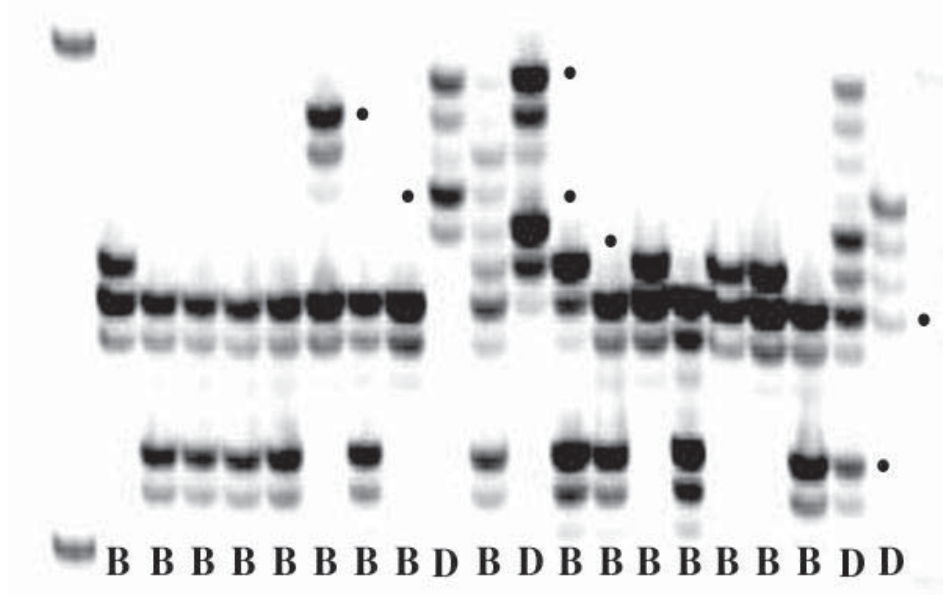
Figure 4. Amplification products of a pair of simple sequence repeat primers in Puccinia triticina . Bands with dots are alleles. B = isolate from bread wheat; D = isolate from durum wheat.